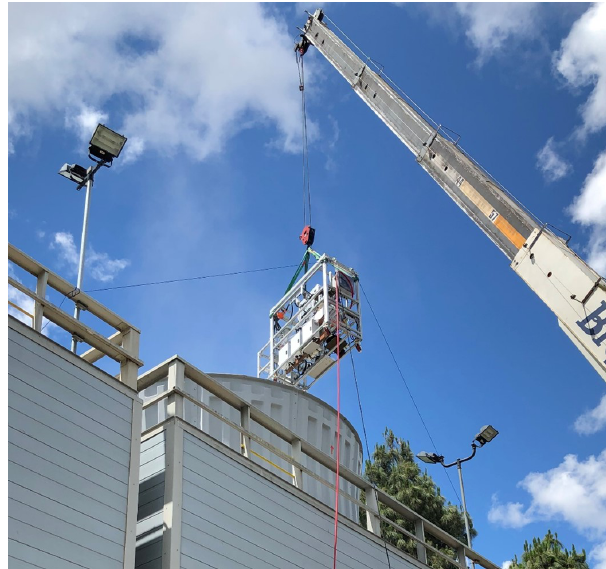
Figure 2. Instrument package in place above a cooling tower.